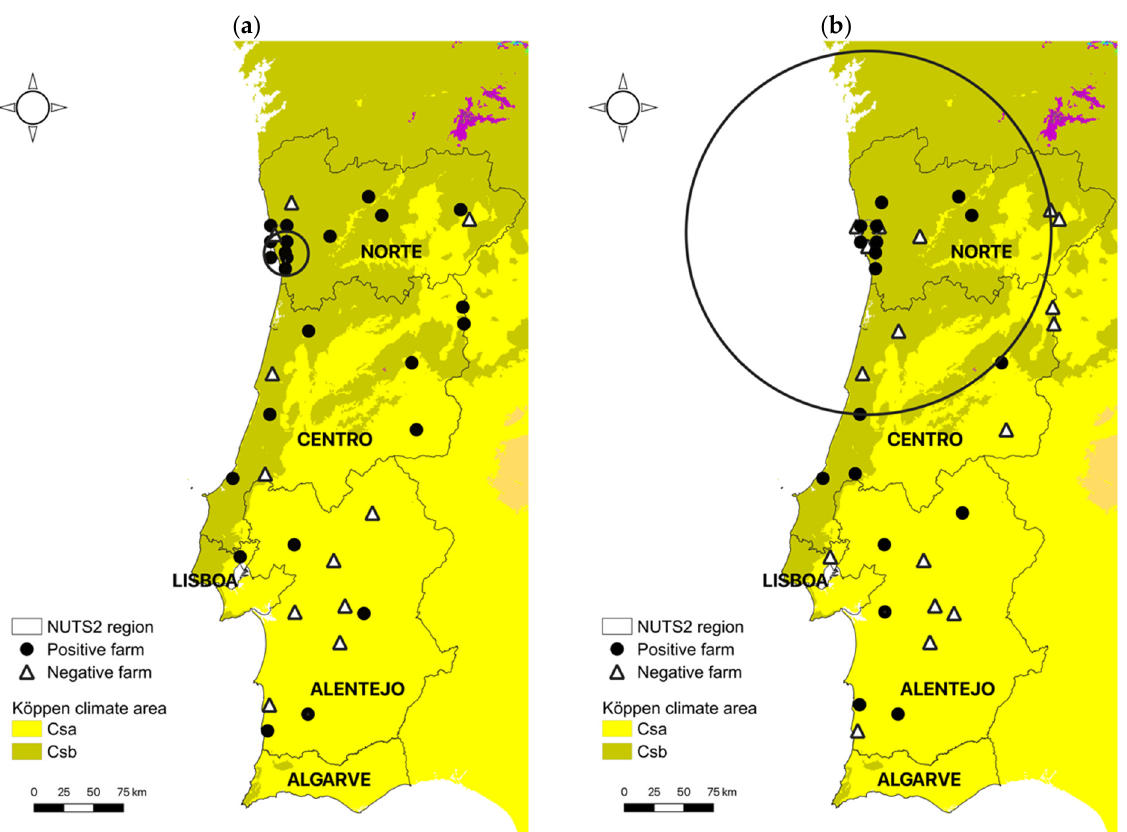
Figure 1. Locations of Neospora caninum ( a ) and Toxoplasma gondii ( b ) positive and negative farms in the different NUTS2 regions in continental Portugal. Significant clusters of infection detected by spatial cluster analysis represented by circles (small circle with arrow for N. caninum and large circle for T. gondii ). Csa and Csb Köppen climate areas according to Beck et al. 2018 [29]. © EuroGeographics for the administrative boundaries.